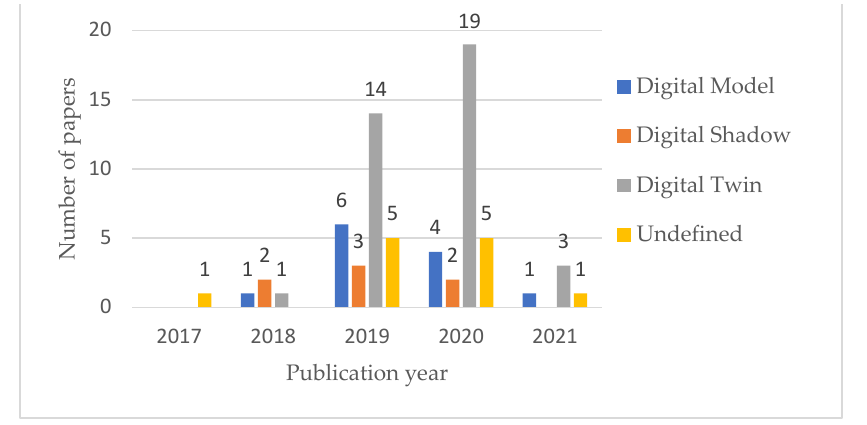
Figure 13. Number and type of DT by year. Table 8. Number and type of DT by